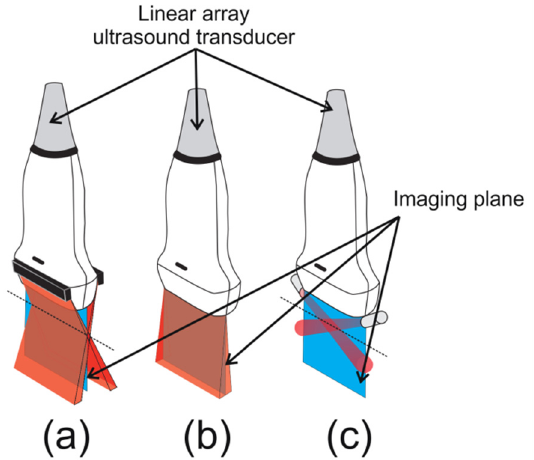
Figure 1. ( a ) Standard dark-field illumination scheme to acquire photoacoustic (PA) image in reflection mode; a rectangular optical fiber terminal illuminates the surface of the target. ( b ) Bright-field illumination where the laser beam and the acoustic field are coaxially aligned. ( c ) Proposed long-axis lateral illumination architecture; the variation of light incidence angle provides wide illumination to the surface of the target.